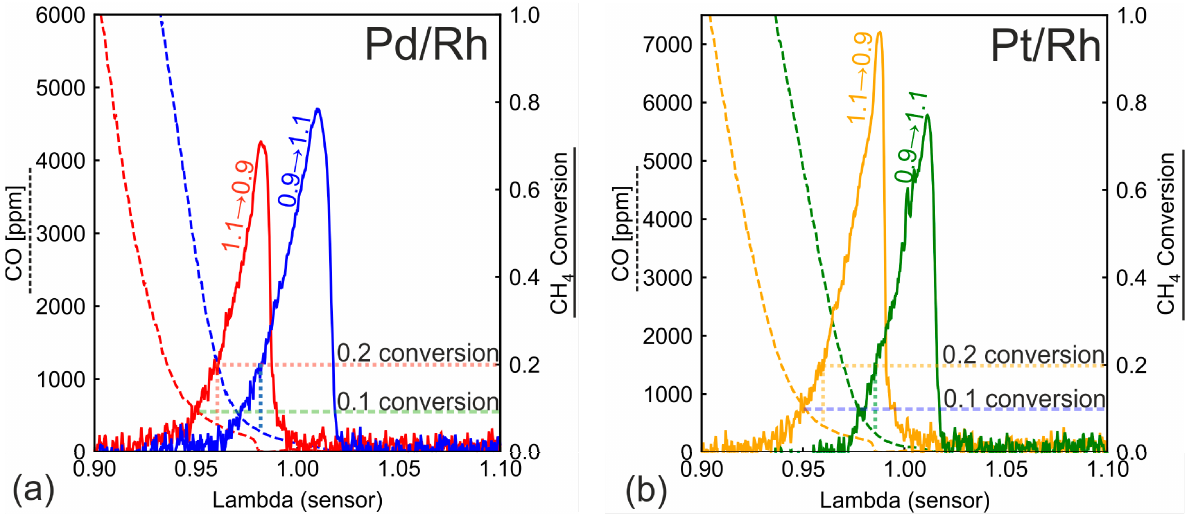
Figure 7. CO concentration and CH 4 conversion during λ ramp-up and λ ramp-down in ( a ) the Pd/Rh and ( b ) the Pt/Rh catalyst at temperature 360 °C.